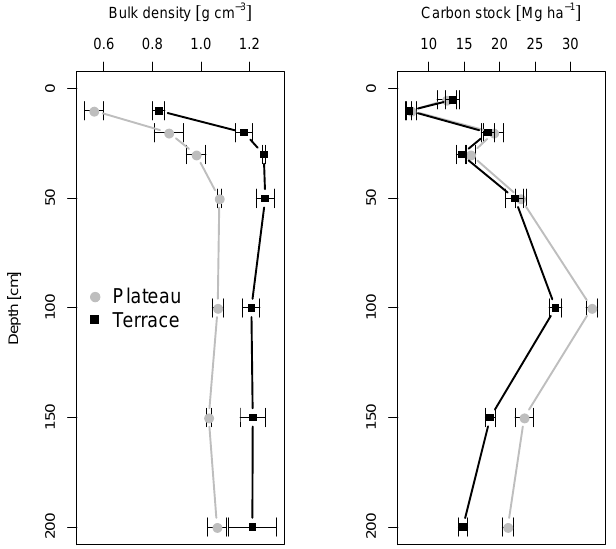
Figure 6. Plot of bulk density (gcm − 3 ) and carbon stocks (Mgha − 1 ) against soil depth. Pronounced differences of below- ground carbon stocks between terrace and plateau occur in deeper layers (Depth >